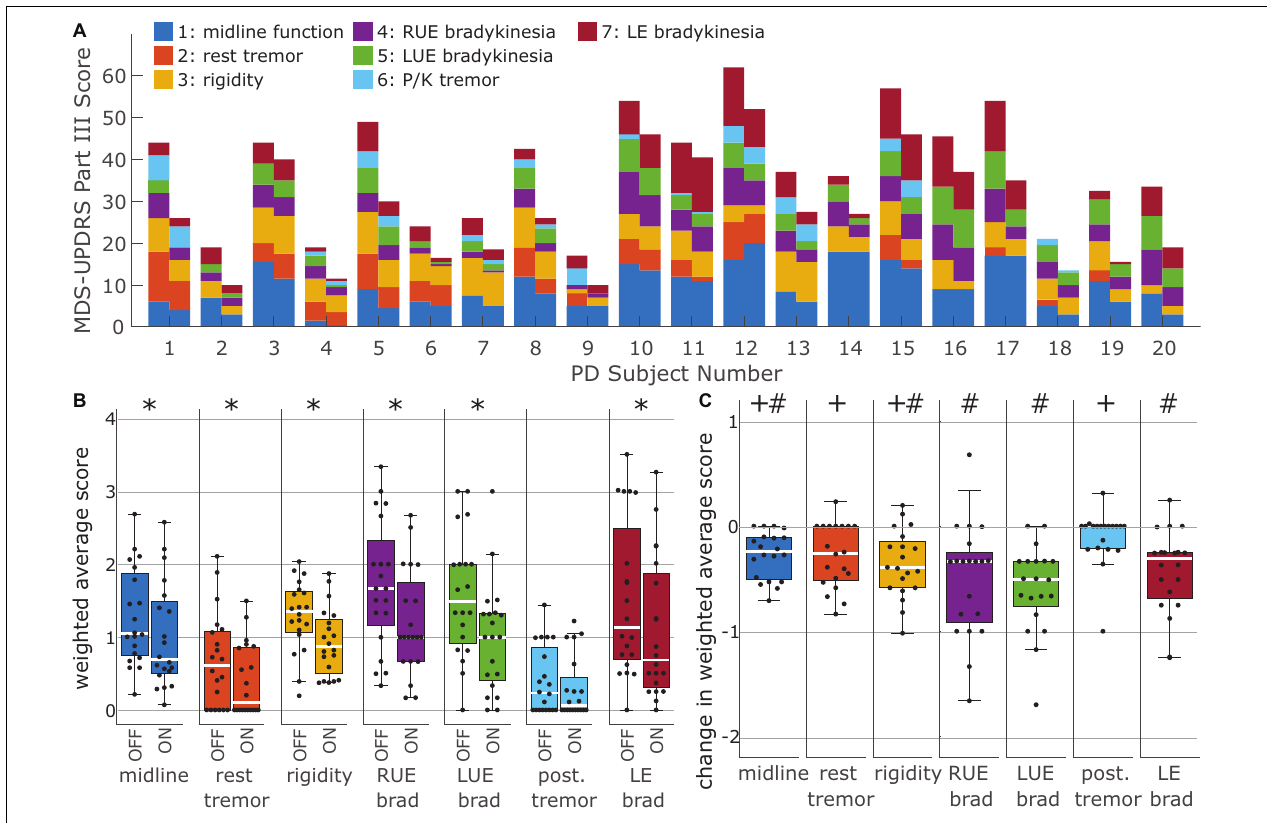
FIGURE 1 | Clinical heterogeneity of responses to L-Dopa therapy across subjects. (A) MDS-UPDRS motor factor score profiles of short-duration L-Dopa responses across all subjects. Color-coding by motor factors represents the raw sum of item scores that belonged in a given motor factor according to (Goetz et al., 2008). Motor factors 1–7 consisted of 8, 6, 5, 3, 3, 4, and 4 MDS-UPDRS Part III items, respectively (see Supplementary Table 2 ). (B) Factor scores expressed as weighted averages of the individual items, where weightings were obtained from Goetz et al. (2008) (see Supplementary Table 2 ). Weighted average scores are shown in the same scale as individual MDS-UPDRS items (i.e., 0—Normal, 1—Slight, 2—Mild, 3—Moderate, 4—Severe). Asterisks denote factors in which SDR was significant in terms signed rank tests and Bonferroni correction for seven multiple comparisons. (C) Change in weighted average scores. Significant differences from post hoc Wilcoxon signed rank tests with Bejamin-Hochberg correction are denoted by either “#” (if different from postural tremor) or “+” (if different from left upper extremity